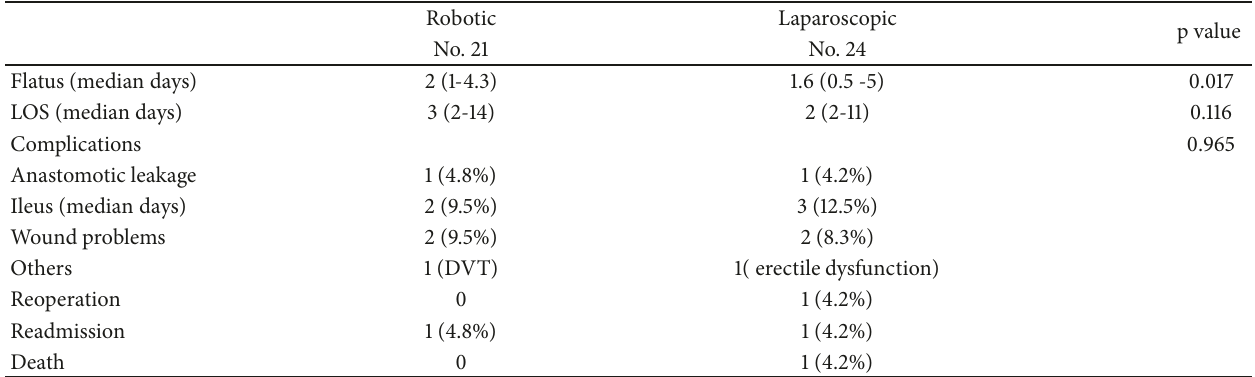
Table 3: Immediate Postoperative